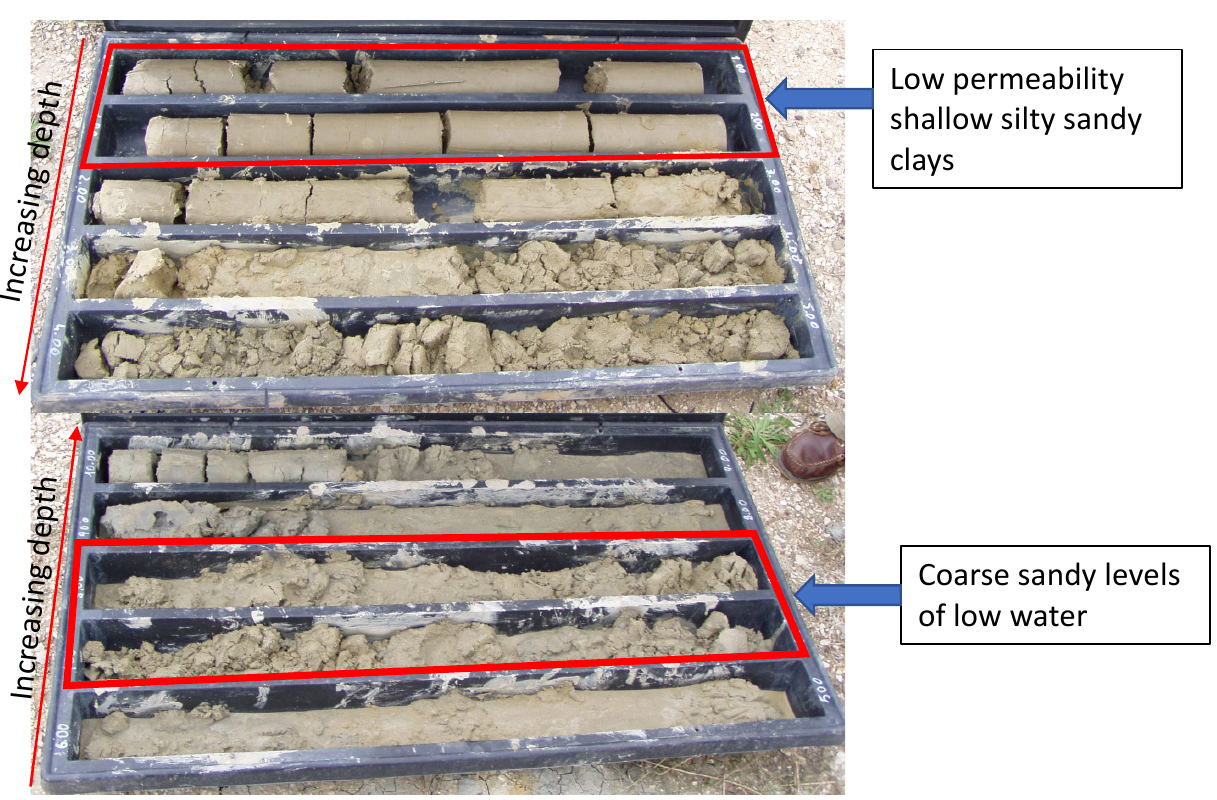
Figure 10. Samples from a borehole survey made close to the Terra Montonata well. The upper part of the figure represents the samples from 0 to 5 m below the ground, and the lower part represent the samples from 5 to 10 m below the ground.